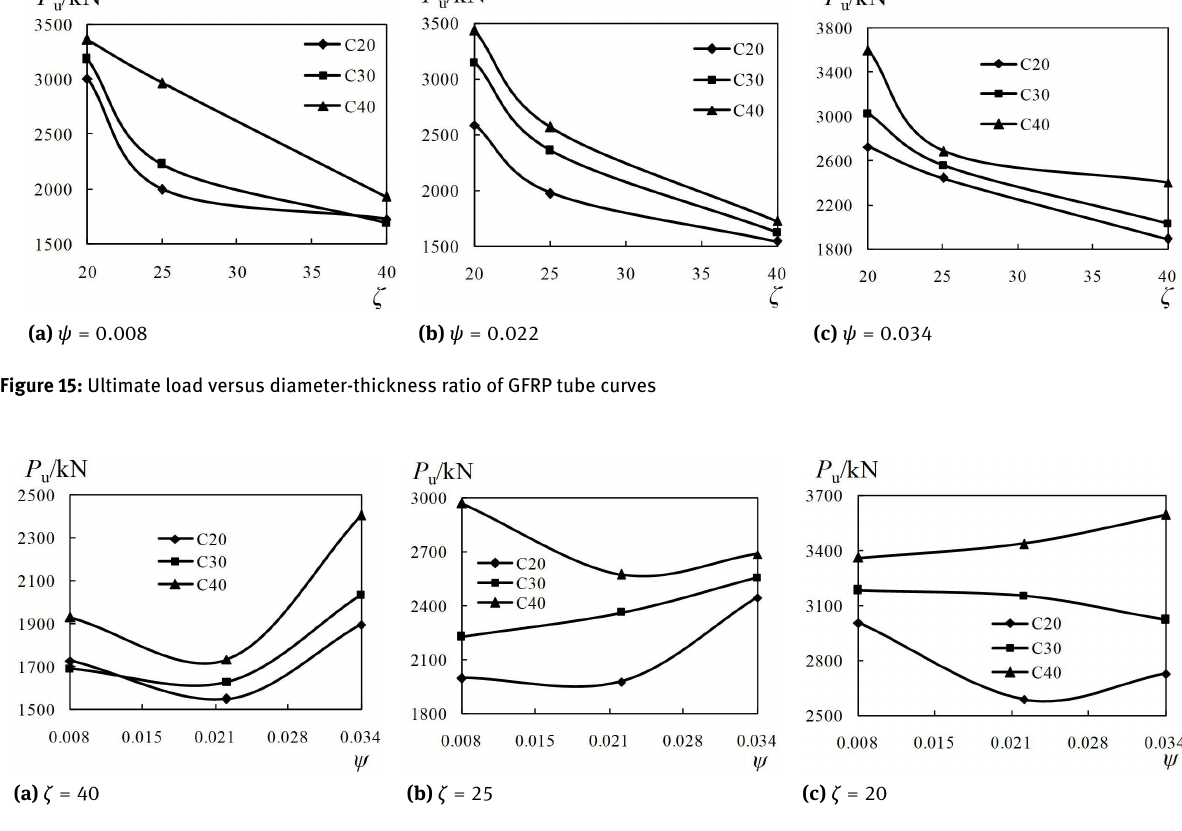
Figure 16: Ultimate load versus steel ratio